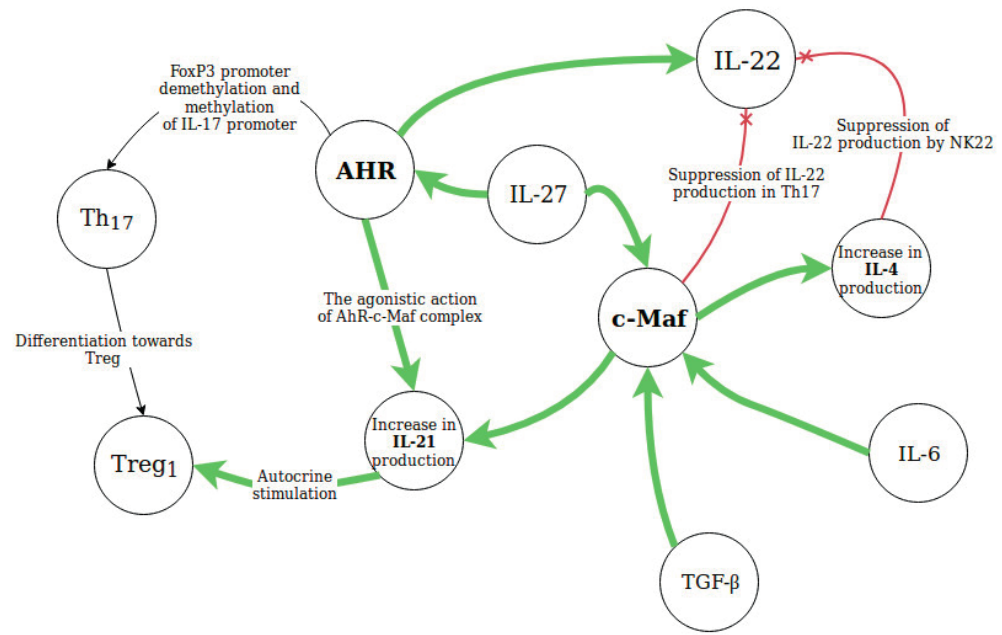
Fig. 2. The scheme shows the relation between IL-22, AHR and c-Maf. The demethylation of FoxP3 and methylation of IL-17 promoter requires prior proper AHR stimulation e.g. by FICZ. On the other hand, activated by Notch, AHR along with STAT3 and RORγT potently promote IL-22 secretion in Th17 cells. Similarly activation of AHR by FICZ increases IL-22 production. Bold green line indicate positive influence (induction or activation) while red line nega- tive influence